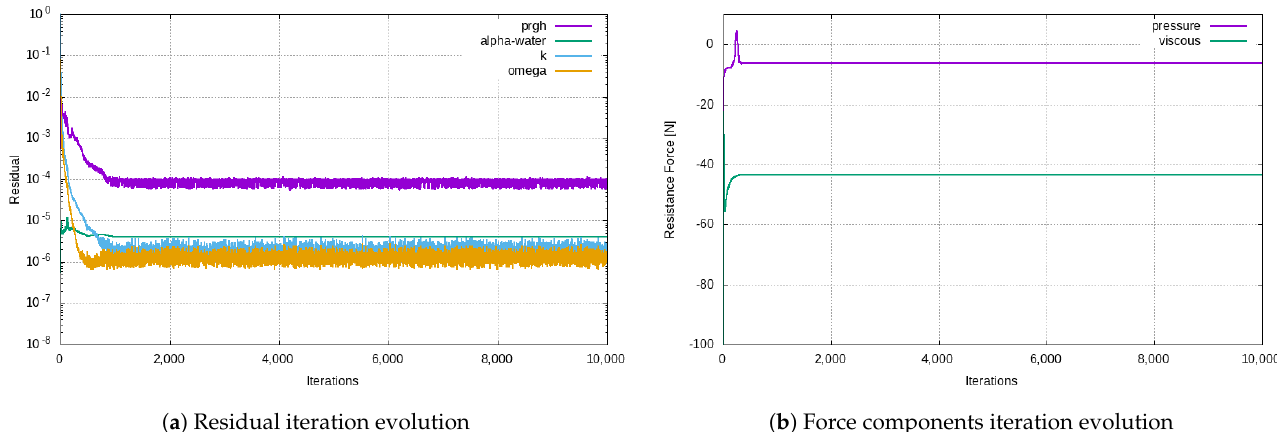
Figure 8. Residual and force components evolution acting on the DARPA SUB-OFF submarine navigating at Fr = 0.466 and H / D = 5.4 using grid 02 with 4,500,437